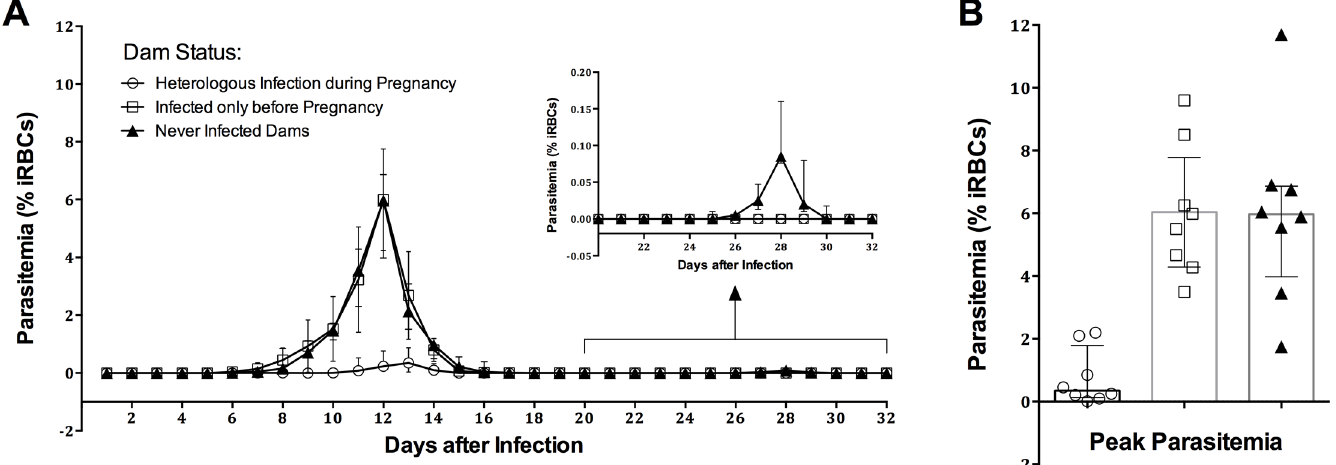
Fig 7. Course of P . chabaudi infection differs between pups born to infected versus uninfected dams. (A) Pups, born to dams with different infection histories (indicated by icons in the figure), were infected with Pcc- CB sporozoites, and peripheral parasitemia followed for up to 32 days; (A, inset) parasite burden between days 22 and 32. (B) Peak parasite burden in pups born to dams that were given HI versus pups born to mothers that were not given HI or were never infected. Data are presented as means with 95% confidence intervals. Differences between groups in the mean values of peak parasitemia were compared using Welch ’ s unequal variances